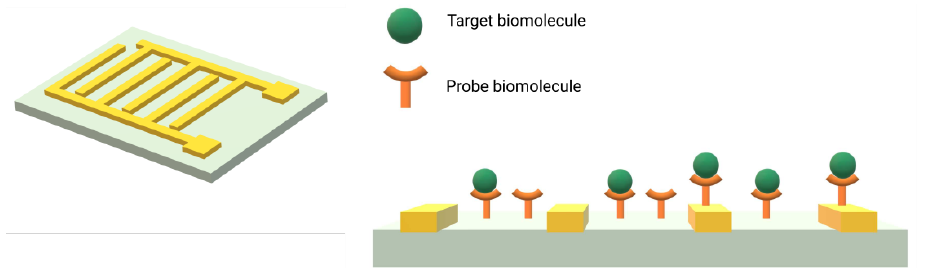
Figure 3. Graphical representation of interdigitated electrodes on a surface ( left ) and cross section view of an interdigitated biosensor after probe capture ( right ). Adapted from Tsouti et al., [3].